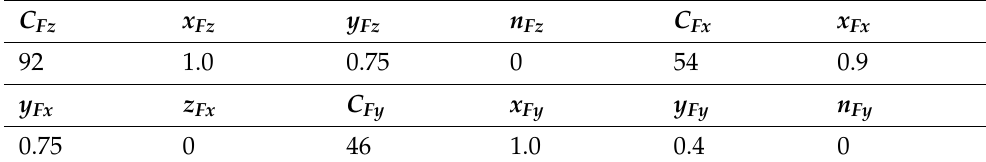
Table 4. Material parameters of direct-drive turntable.